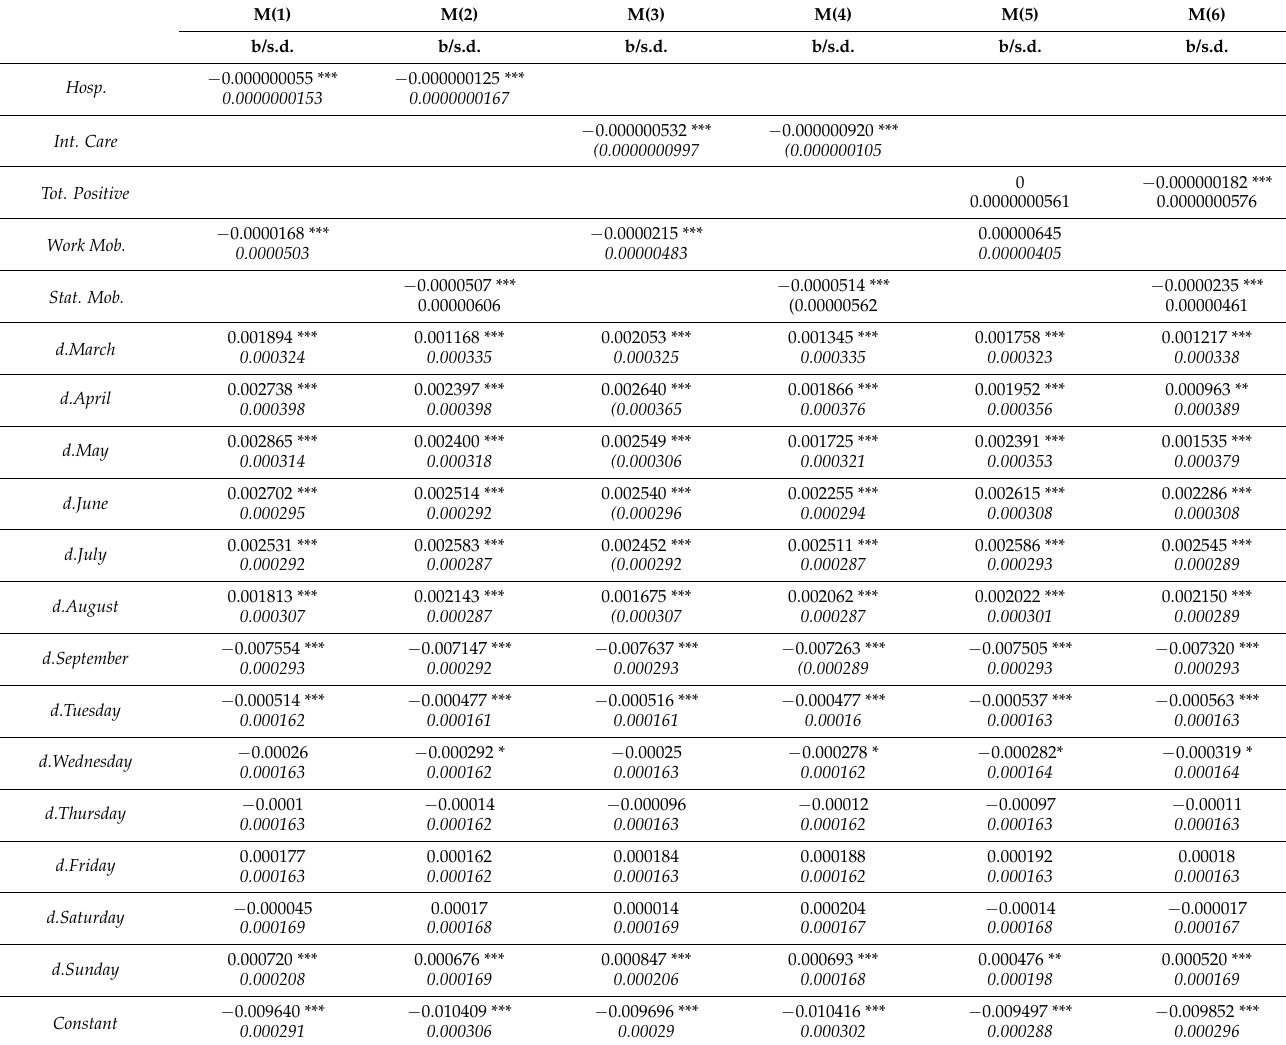
Table 12. Regression Results: Period between 1 January–30